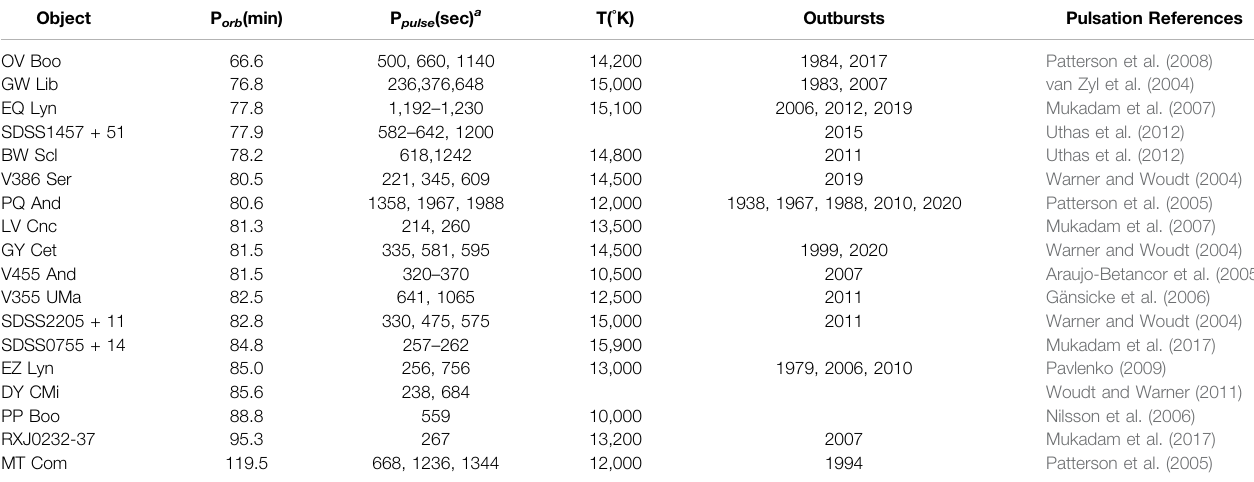
TABLE 1 | Dwarf novae with pulsating white